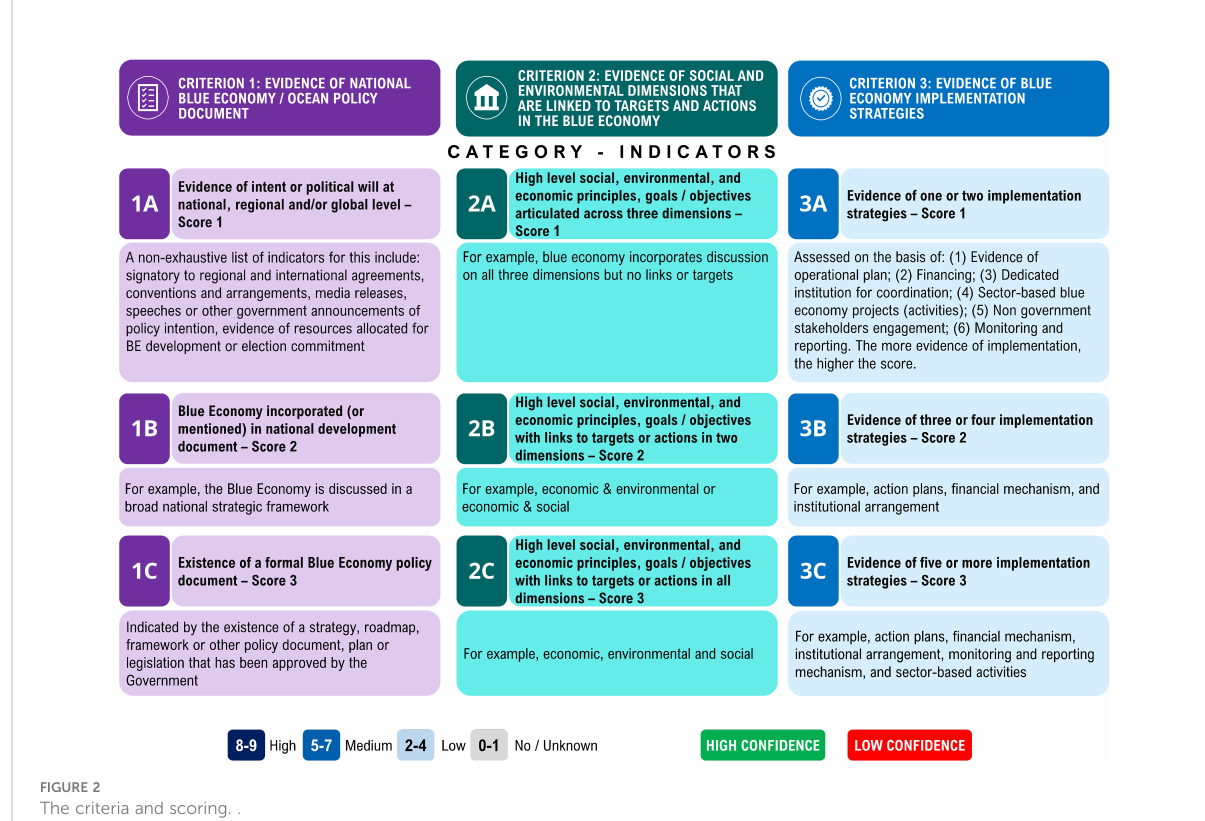
FIGURE 2 The criteria and scoring.